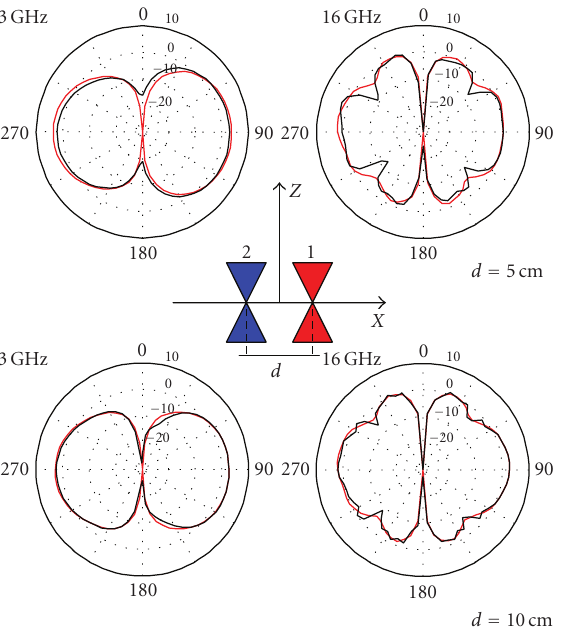
Figure 10: Expected radiation pattern in elevation ( ϕ = 0 ◦ , Z-X plane) (black line) and SC azimuth-averaged approximation (red line). Antenna 1 is excited; antenna 2 is open